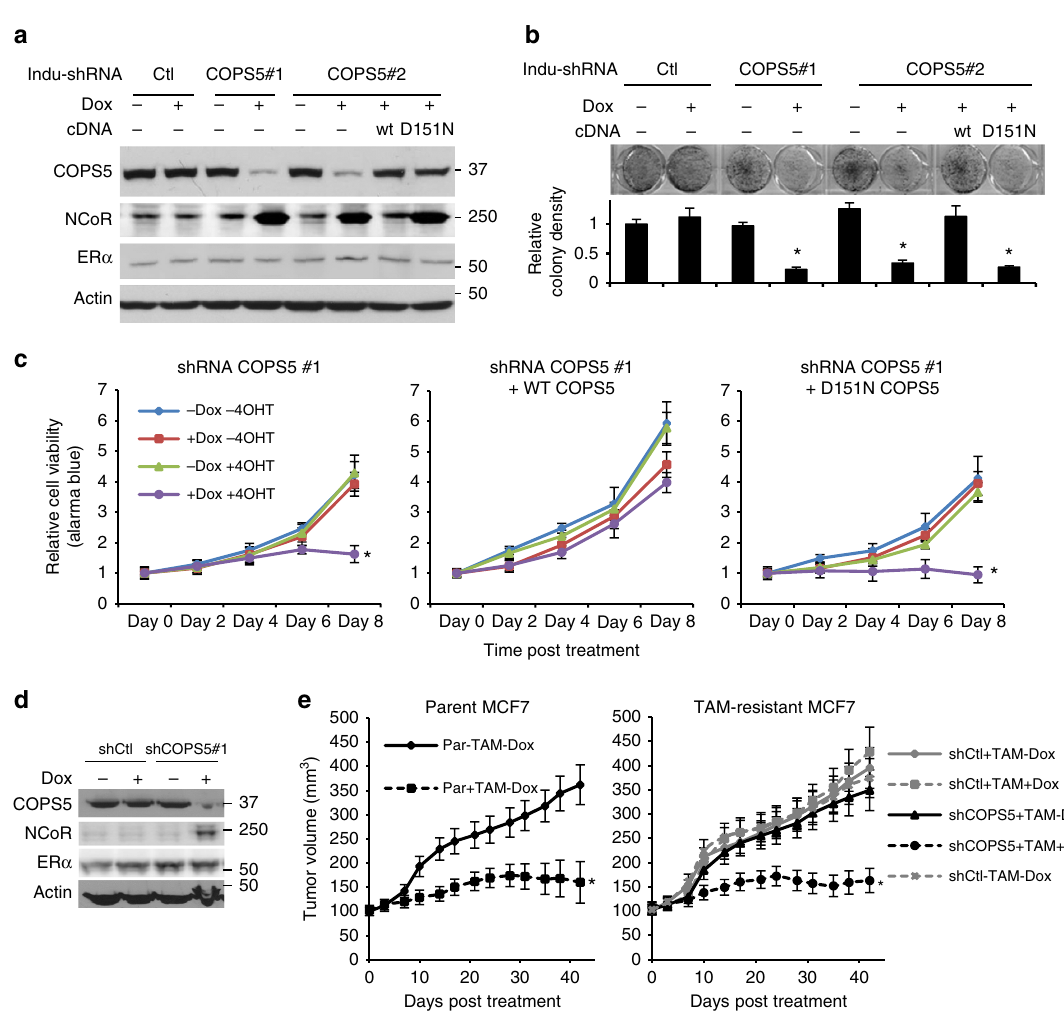
Figure 7 | Genetic inhibition of COPS5 re-sensitizes tamoxifen-resistant breast cancer cells to endocrine therapy. ( a ) Western blot analysis of doxycycline (Dox)-inducible shRNA-mediated knockdown of COPS5 and complementary re-expression of COPS5 cDNAs in the cultured 4OHT-resistant MCF7 clone #1. ( b ) Colony formation assay of 4OHT-resistant MCF7 clone #1 on knockdown by COPS5 shRNAs and rescue by COPS5 cDNAs after 4OHT-treatment for 14 days at 1 m M. *Significant difference compared with basal growth ( P o 0.01, Student’s t -test). ( c ) Growth of 4OHT-resistant MCF7 clone #3 in response to COPS5 knockdown and 4OHT-treatment (1 m M). Data are presented as mean þ s.e.m. from three independent experiments. *Significant difference compared with other samples ( P o 0.01, Student’s t -test). ( d ) Western blot analysis of the xenograft tumours derived from 4OHT-resistant MCF7 clone #3. Cells were stably engineered with doxycycline-inducible shRNAs. ( e ) Volumes of the MCF7 xenograft tumours on treatments as indicated. Data are presented as mean ± s.d. of five mice each group. *Significant difference compared with other